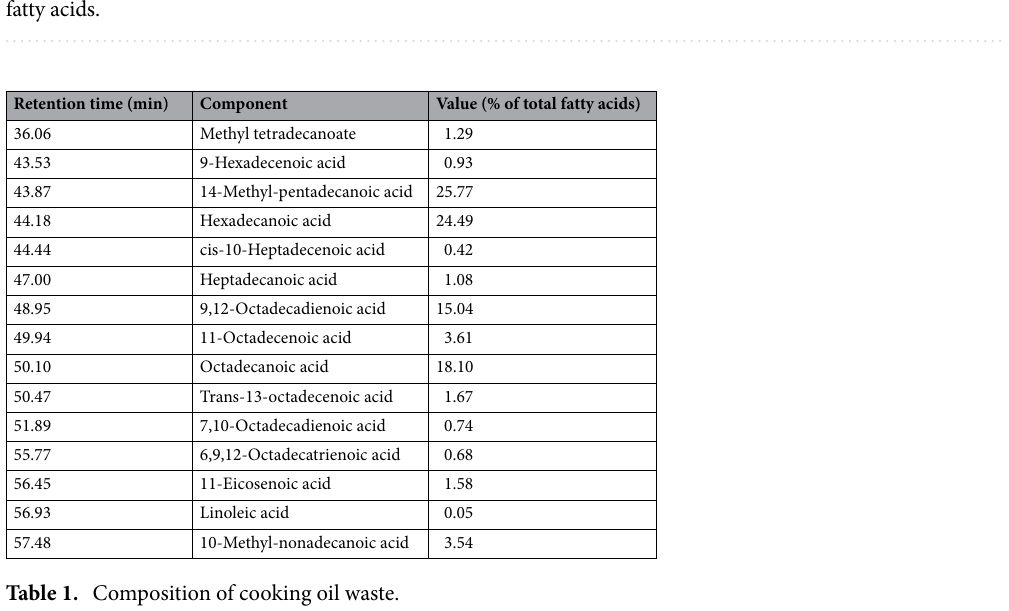
Figure 2. GC/MS profile of cooking oil waste composition and the labeled peaks represents the most common fatty acids.